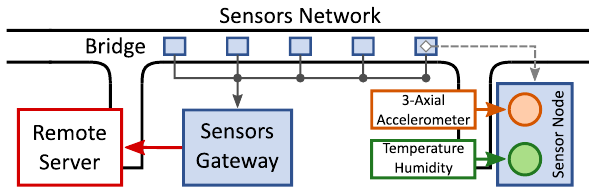
Figure 1. Monitoring system installation.